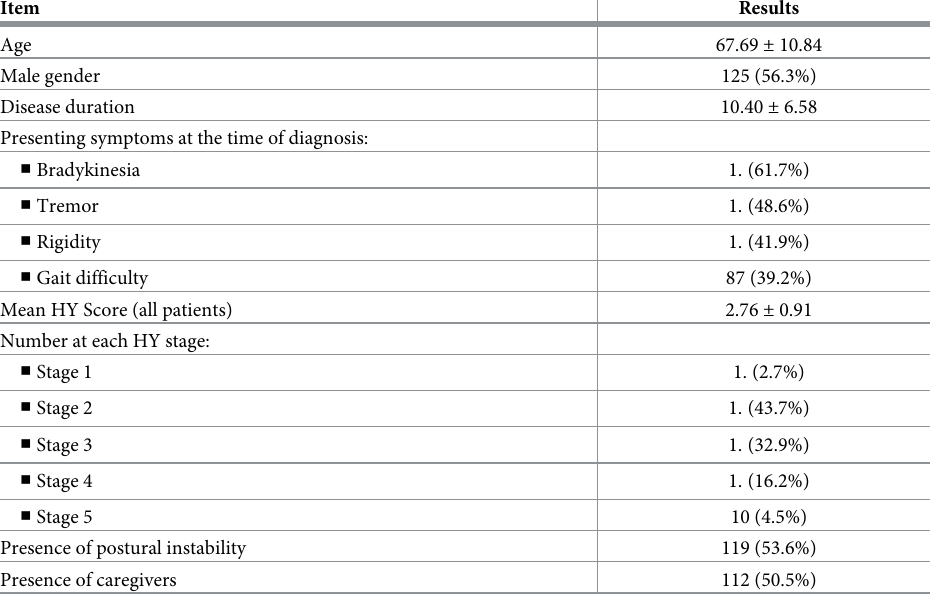
Table 1. Demographics of the 222 PD patients who completed the Parkinson’s disease patients’ concerns